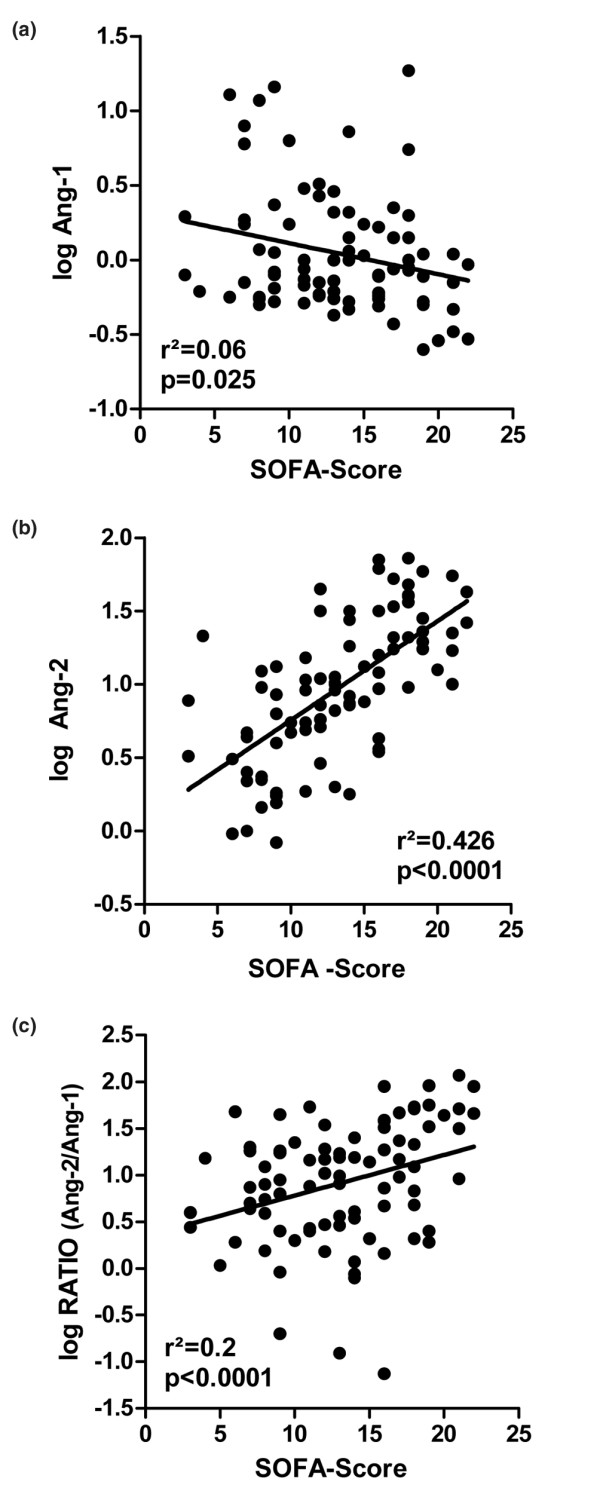
Circulating angiopoietin-1 and angiopoietin-2 concentrations correlate with severity of illness in critically ill patients. Scatter plots showing in 94 critically ill patients the correlation between Sequential Organ Failure Assessment (SOFA) scores and (a) circulating angiopoietin-1 (Ang-1) concentrations, (b) angiopoietin-2 (Ang-2) concentrations, and (c) the Ang-2/Ang-1 ratio.